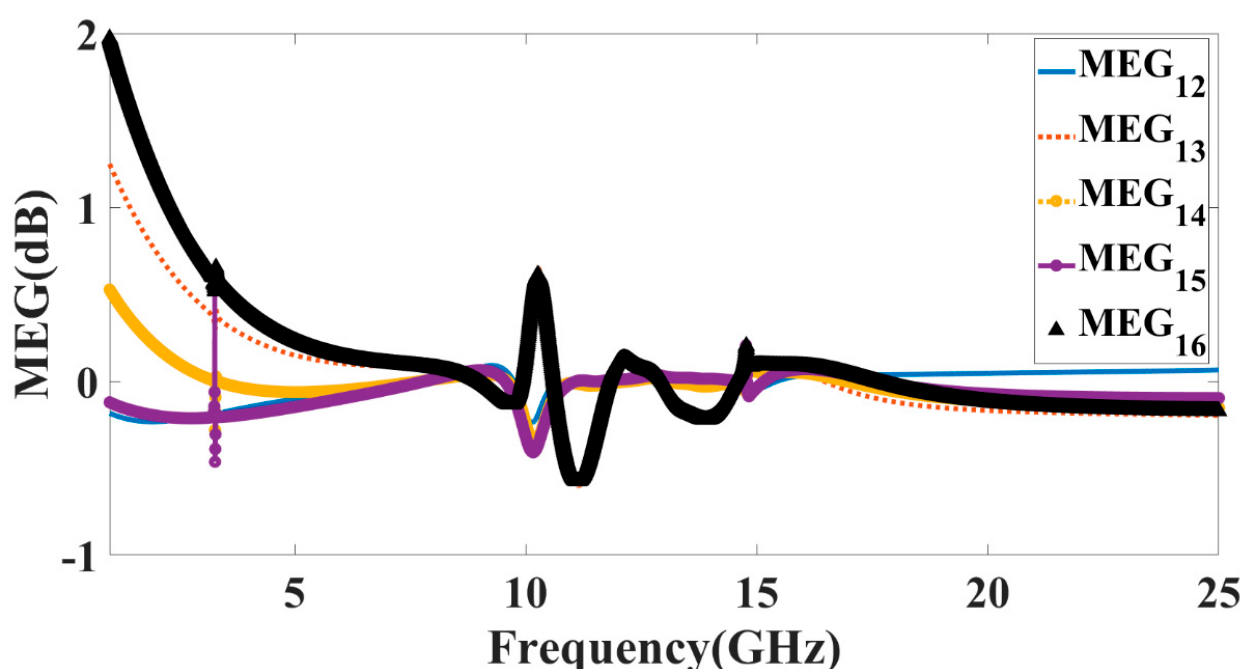
Figure 14. Calculated values of the MEG for antenna Design 5.